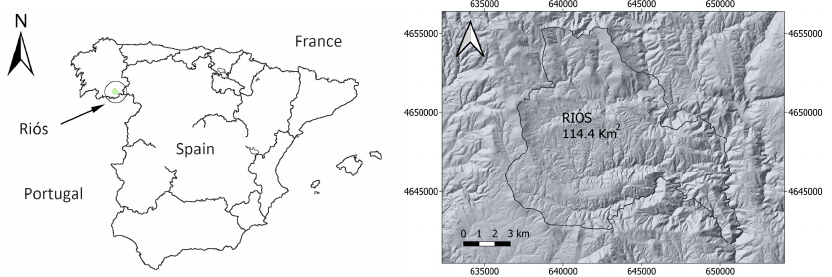
Figure 1. Study region location and extent. Coordinate system and projection ETRS89 29 N.